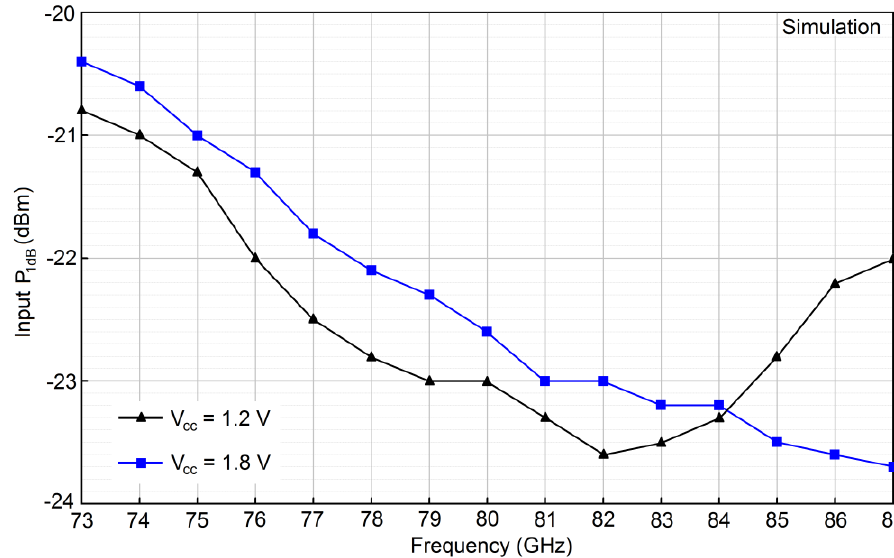
Fig. 5. Simulated IP 1dB versus frequency at different supply